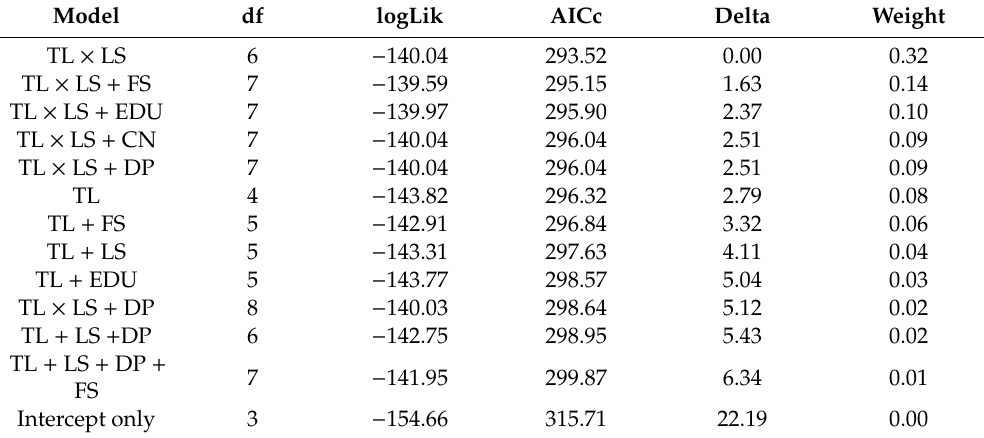
Table 3. Results from Generalized Linear Mixed Models (GLMMs) for livestock loss due to snow leopards. TL = total number of livestock owned, LS = number of larger bodied livestock owned, DP = days livestock housed in pastures, CN = number of corrals, FS = family size and EDU = education status of the households. Here, only those models with Akaike’s Information Criterion (AICc) weights greater than 0.01 are presented (see Supplementary Materials, Table S1 for full models).